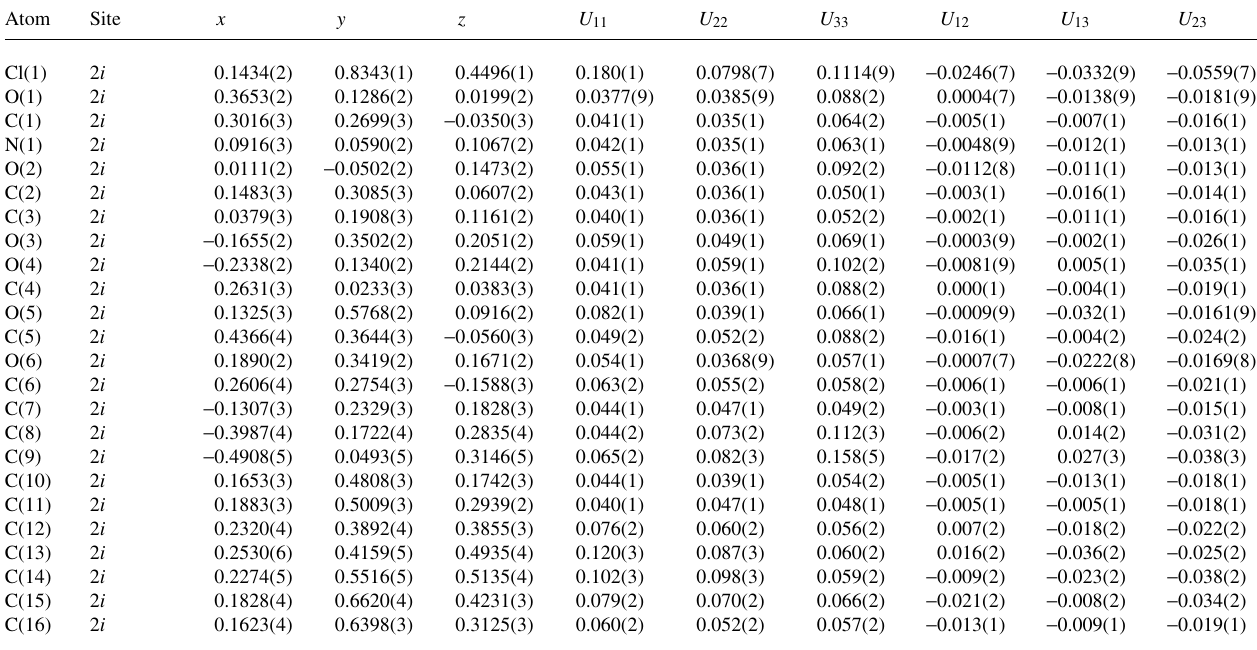
Table 3. Atomic coordinates and displacement parameters (in Å 2 ) .